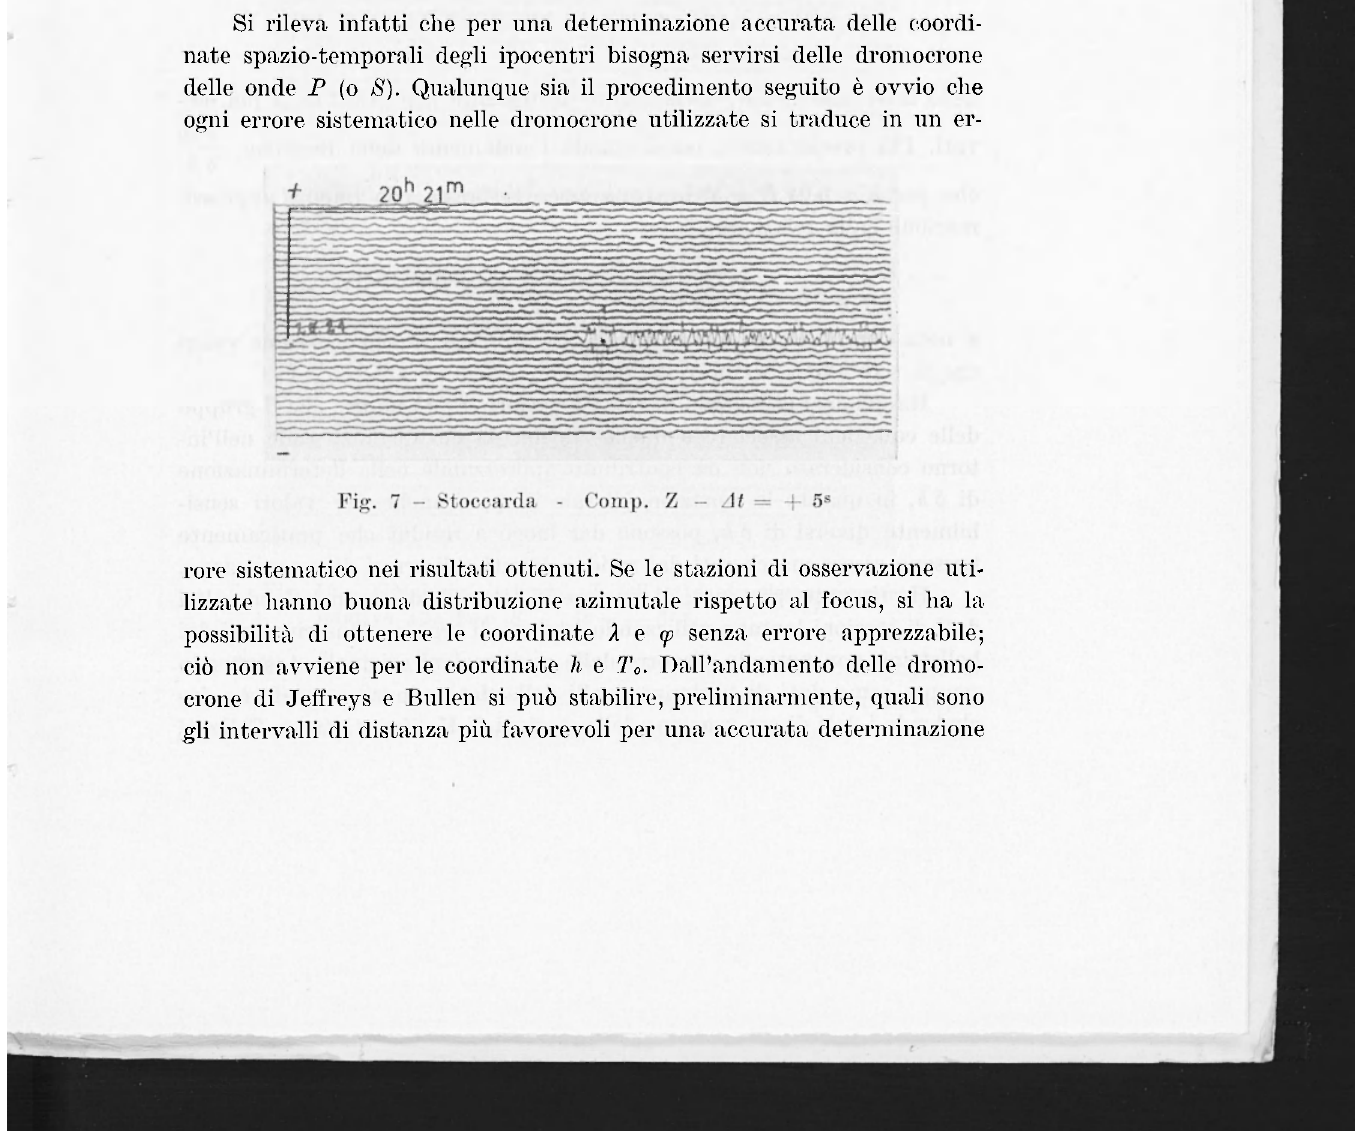
Fig. 6 - Mebstetten - Comp. Z - Ai = + 5